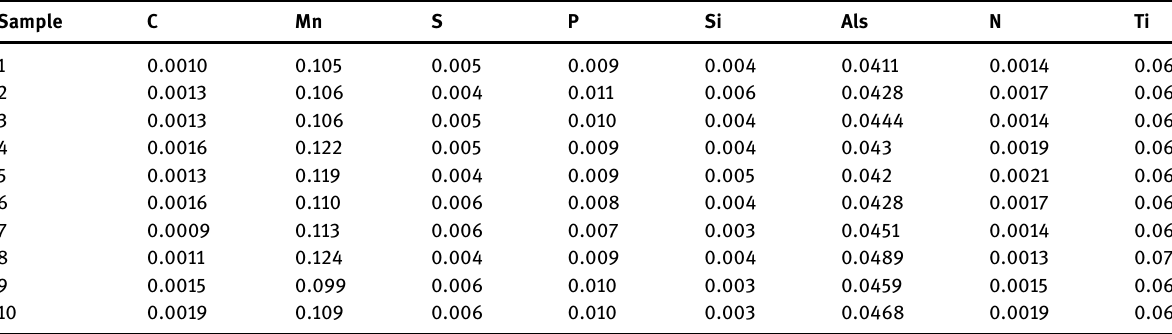
Table 4: Molten steel compositions at the end of the RH process ( % )